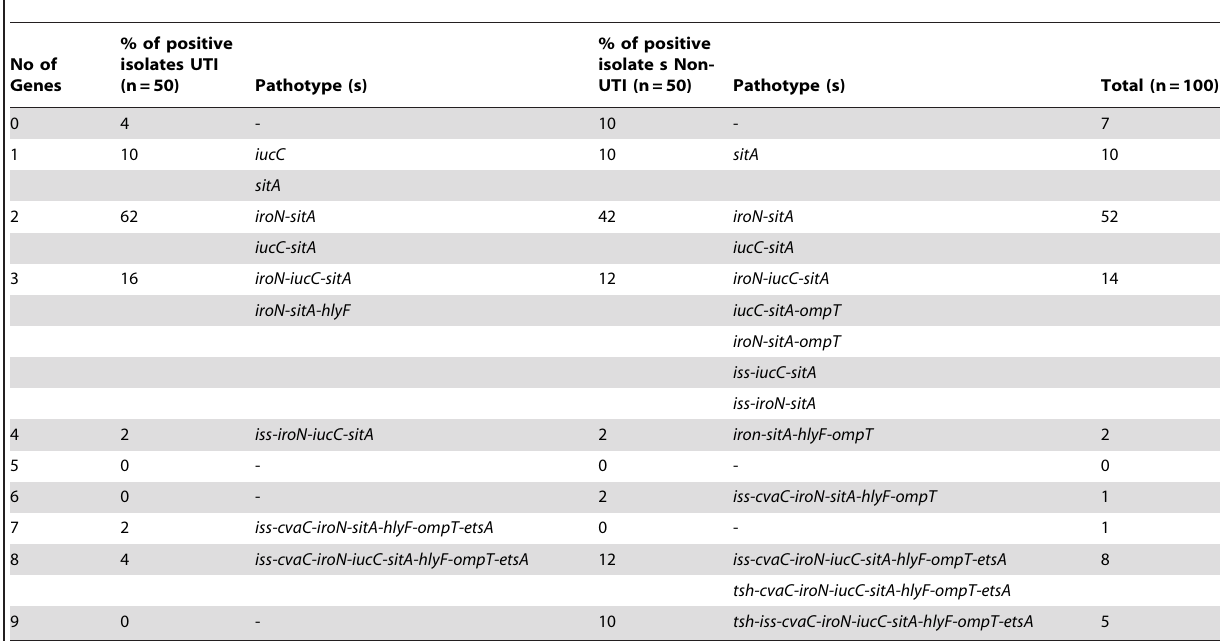
Table 3. Prevalence of different pAPEC-1 gene combinations in human isolates.